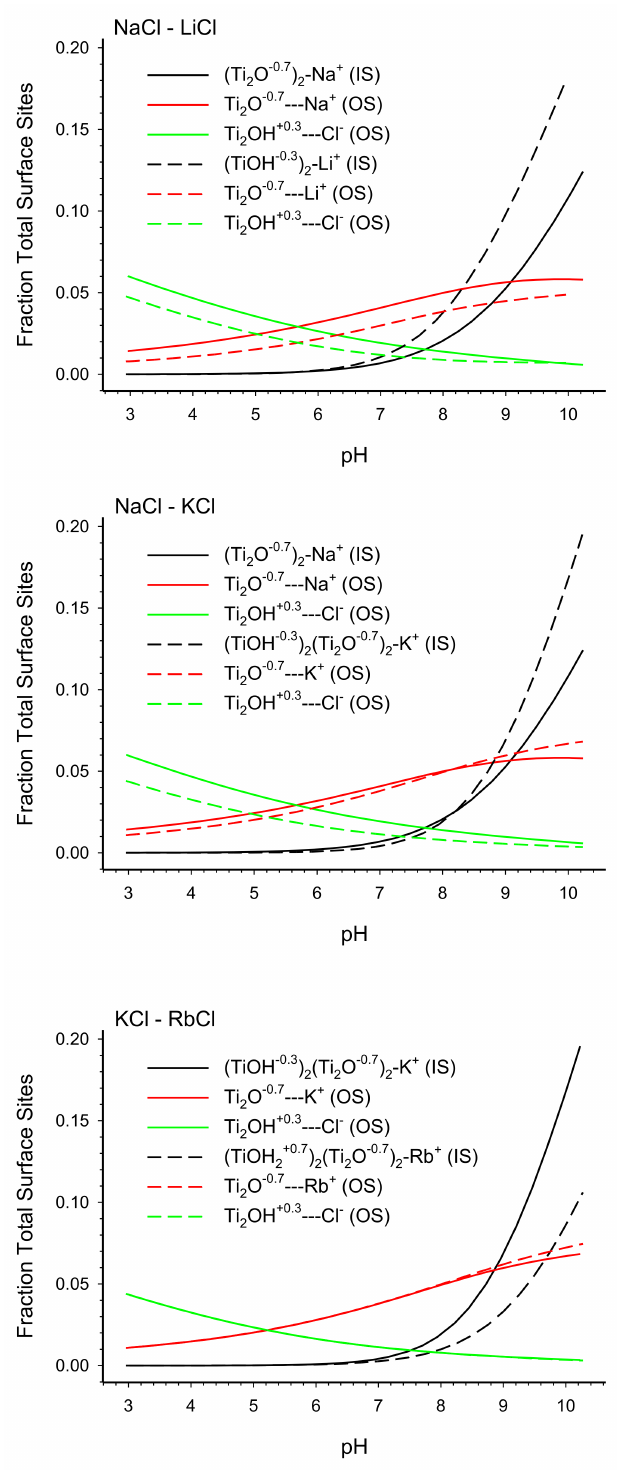
Figure 6. Distribution of surface species on the 4 nm sized anatase sample showing the effect of electrolyte media, at 0.3 m ionic strength. The plots show the inner-sphere (IS) and predominant outer-sphere (OS) electrolyte surface